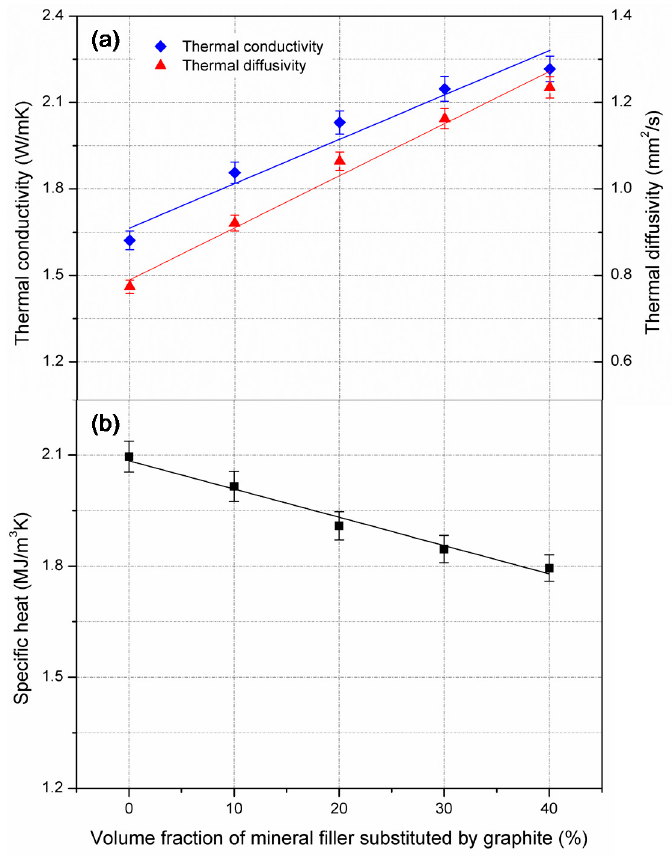
Figure 3. Effect of graphite on thermal characteristics of asphalt mixtures. ( a ) Thermal conductivity and diffusivity; ( b ) Specific heat.